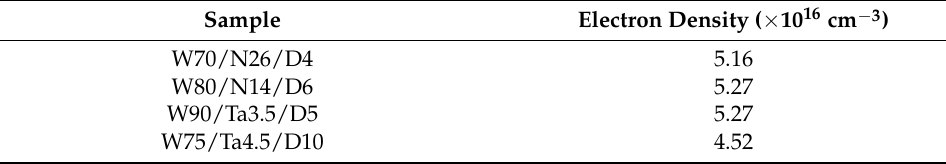
Table 4. Semi-quantitative estimation of the D concentration in the four analyzed samples, com- Table 2. Electron density estimated form the FWHA of the H α pared to the nominal concentration given by the GDOES analysis.